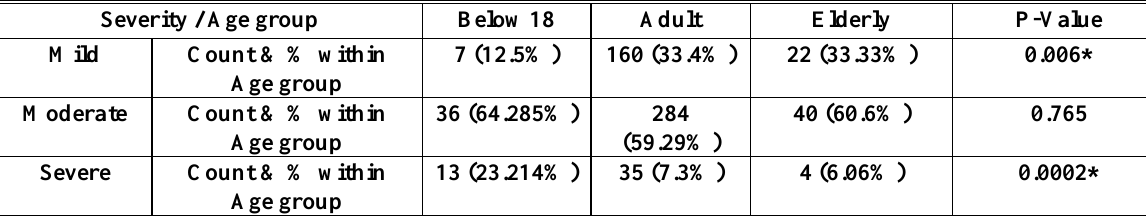
Table 8. Severity levels distribution among age